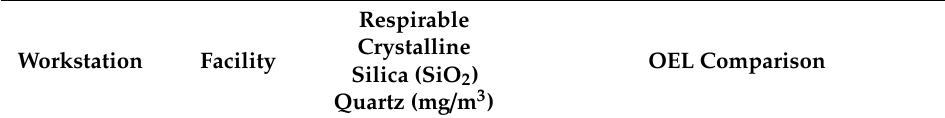
Table 4. Respirable crystalline silica (SiO 2 ) quartz OELs of workstations in comparison to other established